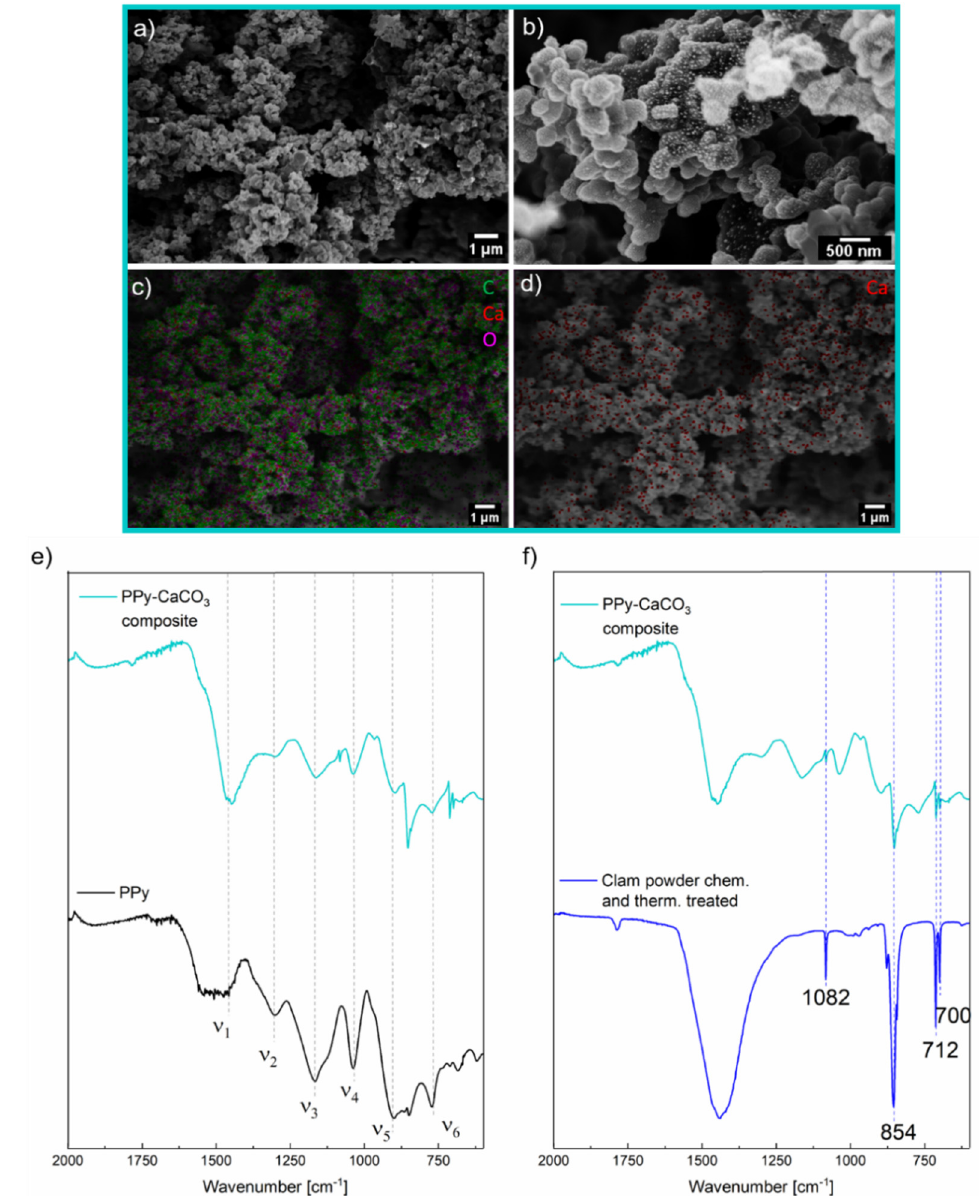
Figure 2. ( a , b ) SEM images of a polypyrrole/CaCO 3 (PPy/CaCO 3 ) composite material and in ( c , d ) the corresponding EDX mapping images. ( e ) ATR IR spectra of PPy/CaCO 3 composite (cyan curve) and clam powder (blue curve), which was used for the synthesis of PPy. Bands at 700, 712, 854, and 1082 cm − 1 are the characteristic aragonite vibrations. ( f ) ATR IR spectra of polypyrrole/CaCO 3 (PPy/CaCO 3 ) composite and PPy synthesized without any template. The dashed lines ( ν 1 – ν 6 ) indicate the characteristic bands of PPy.